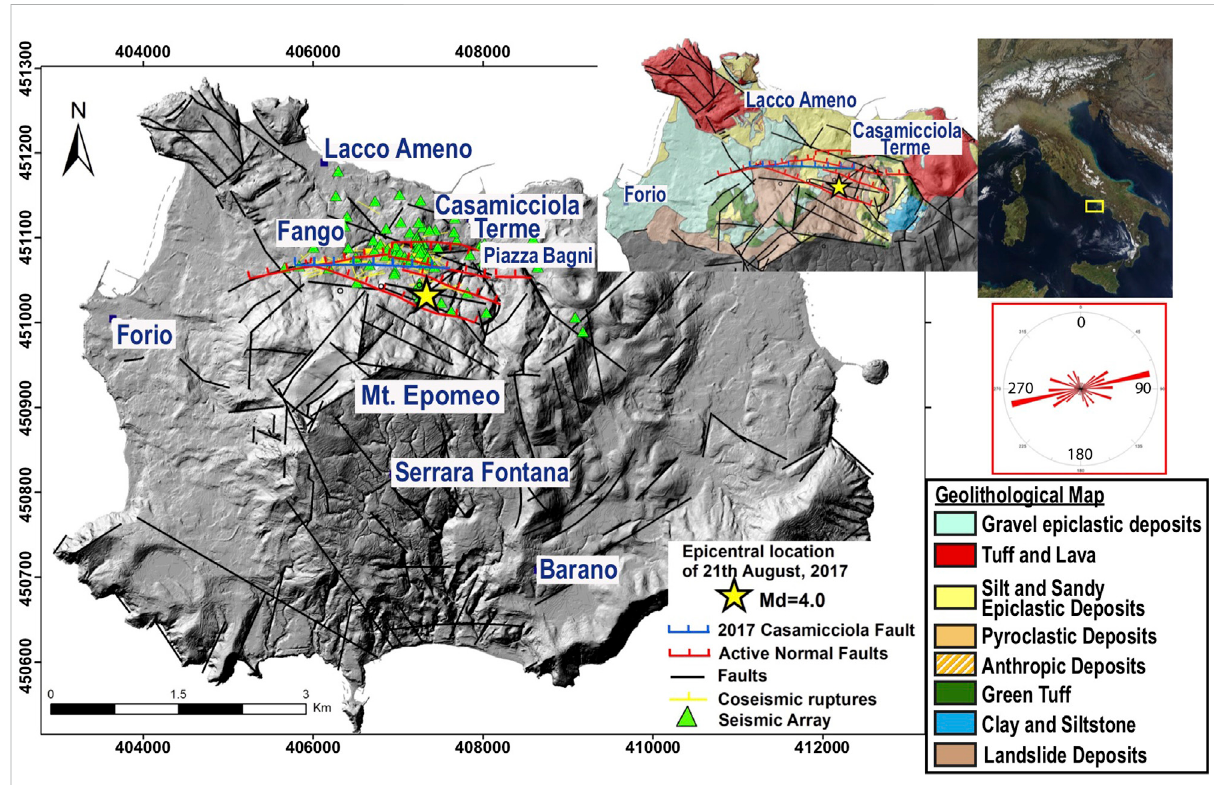
FIGURE 1 Geostructural sketch map on the shaded relief in UTM WGS-84 geographic coordinates by Nappi et al. (2010). The featured stratigraphic units are simpli fi ed from Sbrana et al. (2018). Faults (in black) are from Acocella and Funiciello (1999) and de Vita et al. (2010), and geomorphological lineaments (in black), from Nappi et al. (2010); active normal faults (red lines, marks on down-thrown side) are from Vezzoli (1998) and Tibaldi and Vezzoli (1998); the coseismic ruptures (yellow lines) and causative fault (blue line) of 2017 earthquake and rose diagram of the same are from Nappi et al. (2018b); surface trace of the 2017 earthquake causative fault (blue line) from this paper; and the 21 August 2017 mainshock (the yellow biggest star) is from